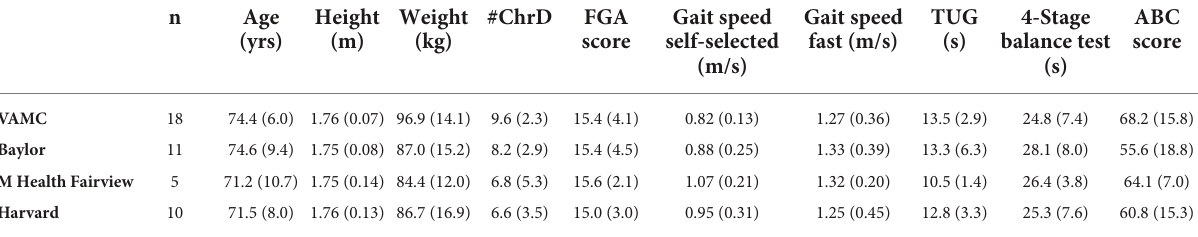
TABLE 1 Characteristics of the 44 individuals from the four different clinical sites enrolled in the study who reached 26 weeks of